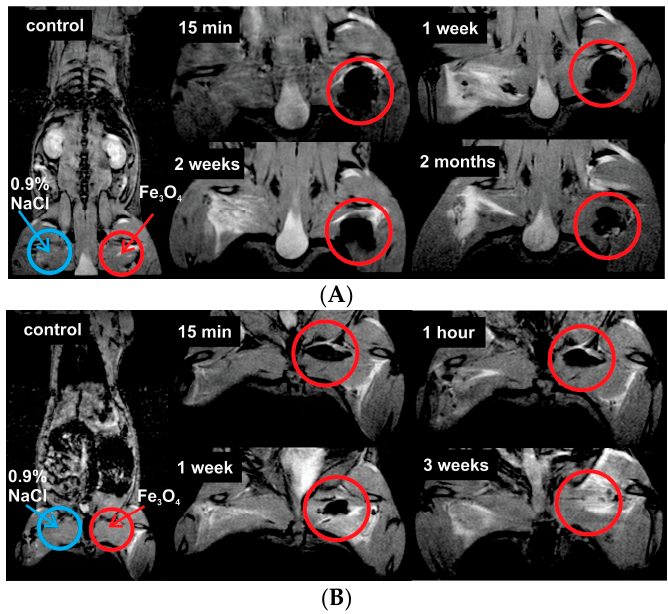
Figure 5. T2W MR coronal slice images of injection site at different time moments after intramuscular injection at dose of ( A ) 520 µg Fe 3 O 4 /kg (in the upper figure) and ( B ) 20.8 µg Fe 3 O 4 /kg (in the lower figure) in the rat left hind paw (red circles). The arrows marks injection site of physiological saline and Fe 3 O 4 nanoparticles solution.